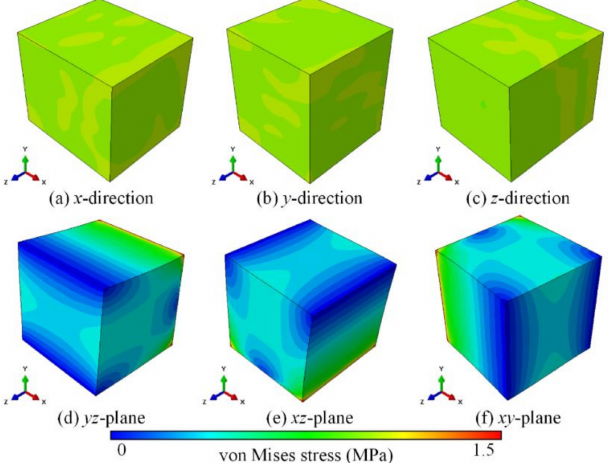
Figure 11. Equivalent linear elastic properties of